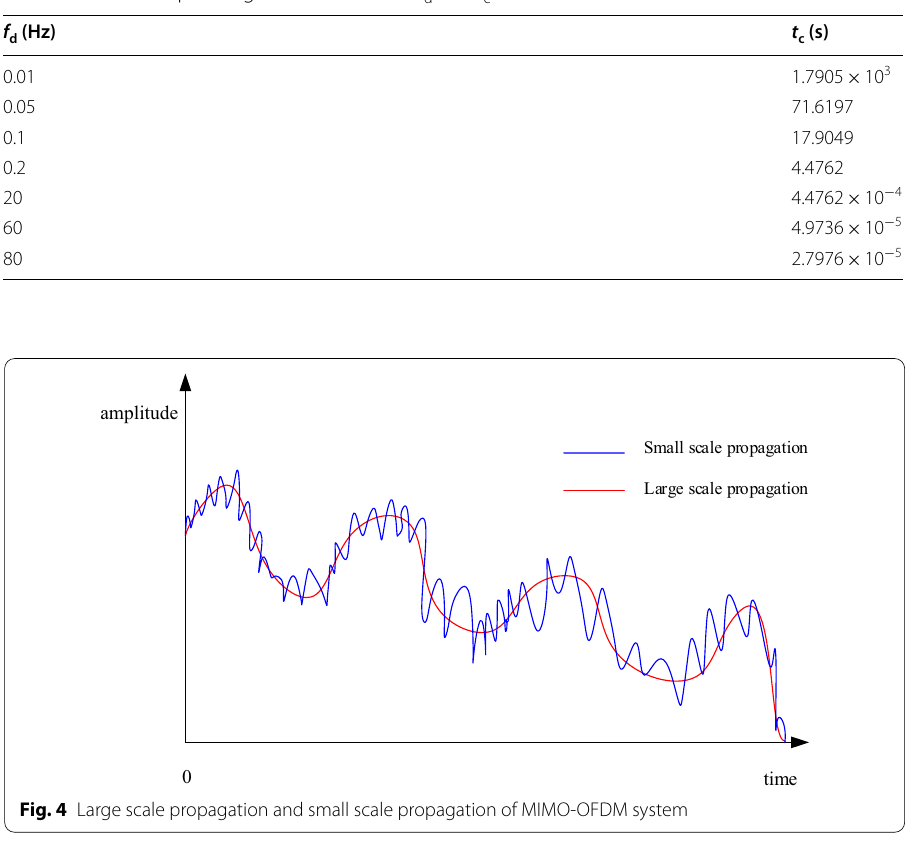
and t in AWGN channels d c